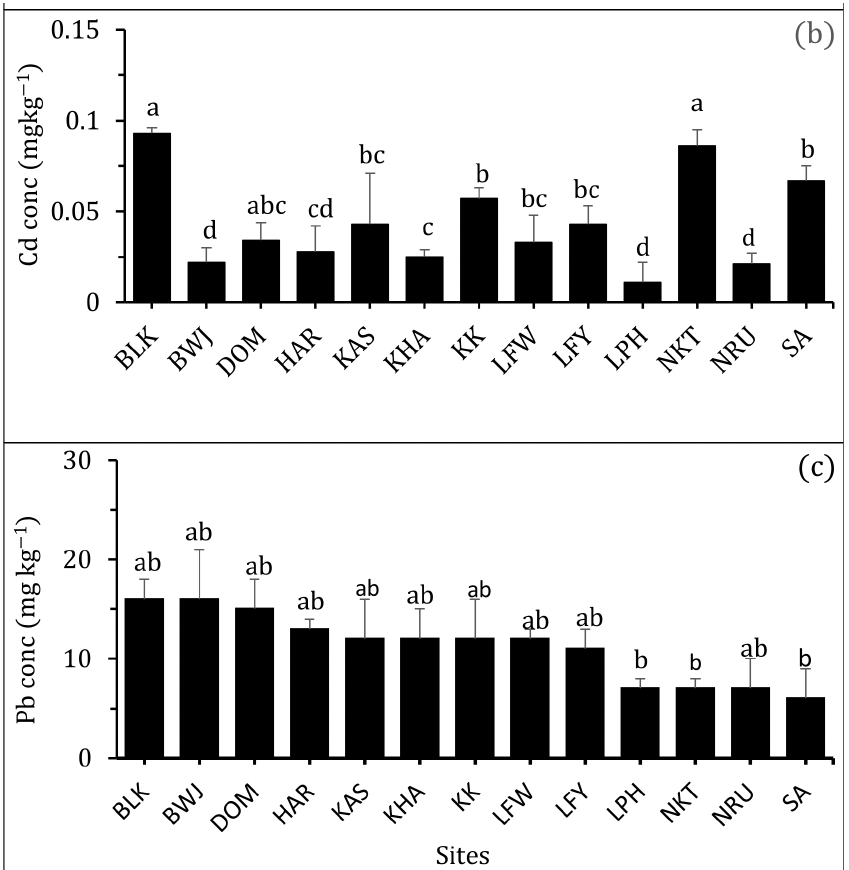
Figure 2. Metal(loids) concentrations in soils of paddy fields of various sites showing ( a ) arsenic, ( b ) Cd, and ( c ) Pb concentrations evaluated by site. BLK: Balaka (17), BWJ: Bwanje (15 and 16), DOM: Domasi (18), HAR: Hara (3), KAS: Kasinthula (20), KHA: Khanda (19 and 19b), LFY; Lufiliya (1 and 2), LFW: Lifuwu (11), LPH: Limphasa (5 and 6), NKH: Nkhate (21 and 22), KK: Nkhotakota (7–9), NRU: North Rumphi (4), and SA: Salima (10, 12–14). Bars that share common letters (a, b, c, and d) are not significantly different from each other.